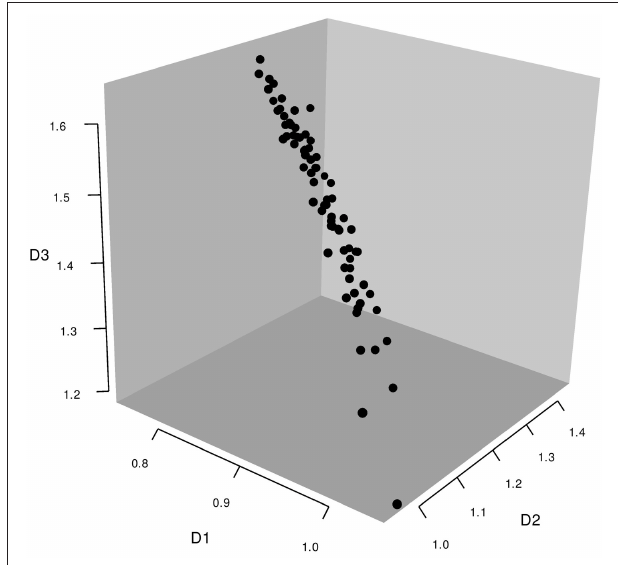
FIGURE 1 | Individual weights in the 3D W-MDS analysis of epistemic adverbs in the Australian sample.